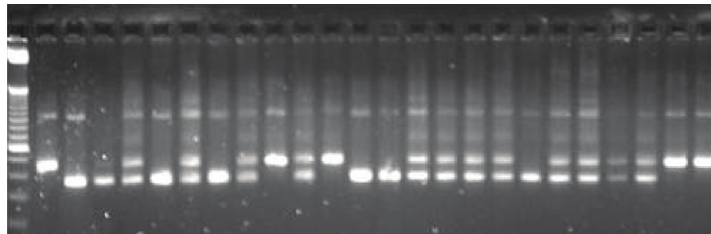
Figure 3: PCR determination of presence or absence of CTTTT tandem repeat. Archived DNA from mercury treated (SJL/JxDBA/2)F2 intercross mice was subjected to PCR using appropriate primers (see Figure 2) and products separated by agarose gel electrophoresis. Lane 1, base pair marker; lane 2, homozygous D tandem repeat; lanes 3 and 4, homozygous S tandem repeat; lane 5, heterozygous D/S tandem repeat; lanes 6–25,